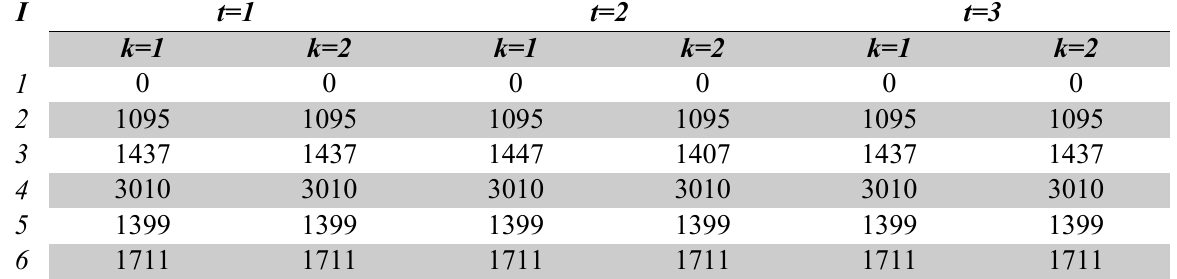
Vehicles used for each service in each time period I